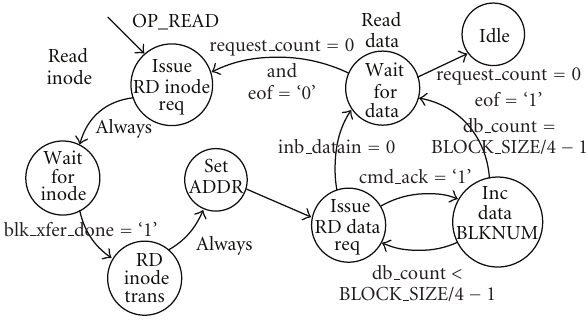
Figure 7: Read file state